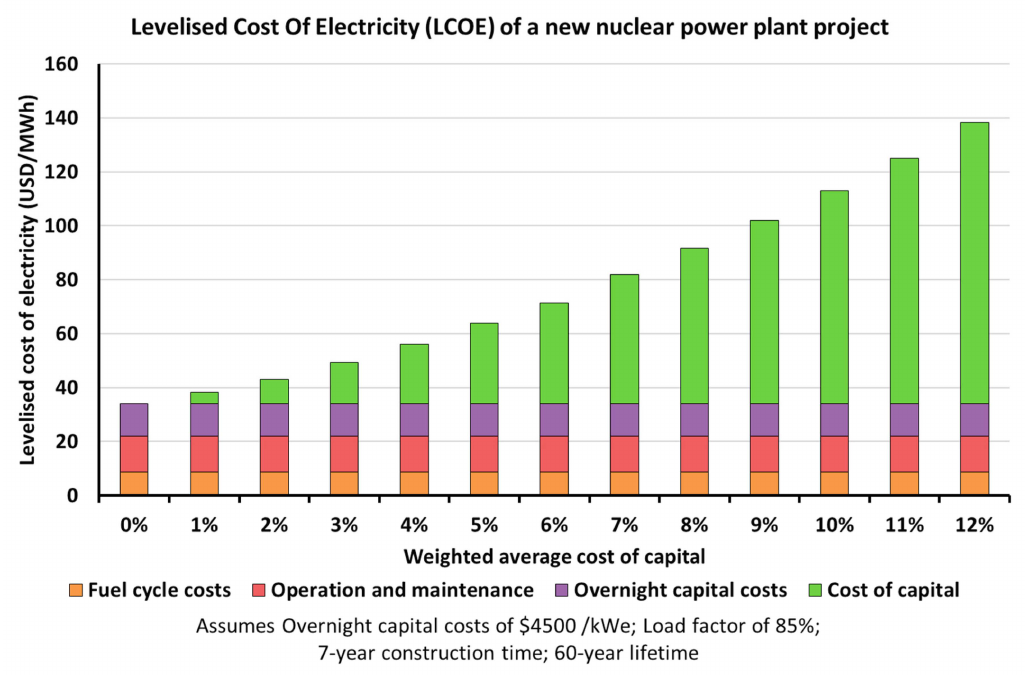
Figure 3. The effect of borrowing costs on the LCOE. Reducing the cost of capital from 8% to 2% halves the LCOE. Reproduced from [32], NEA: